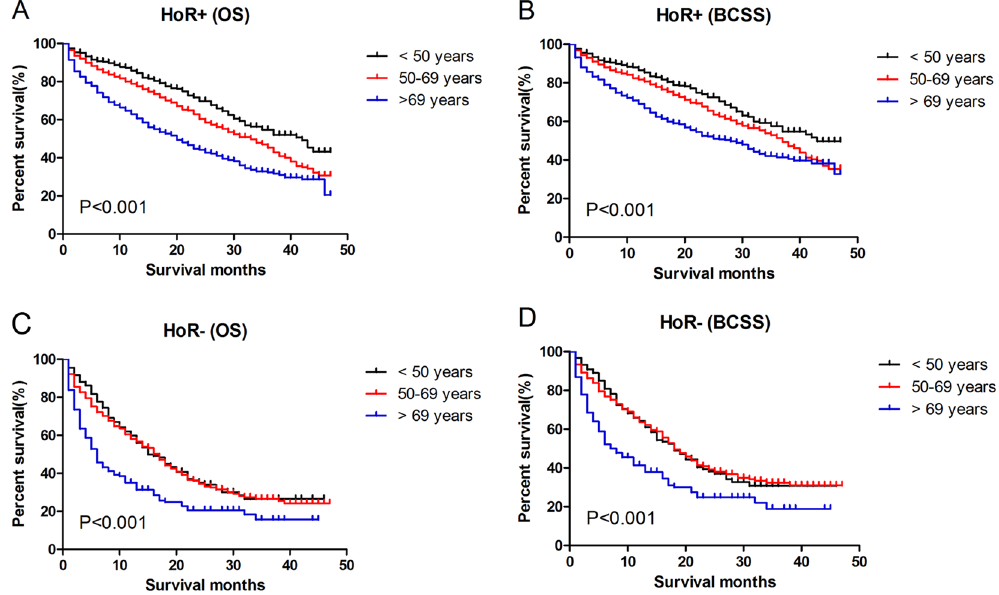
Figure 2. Comparison of survival in breast cancer patients with different hormone receptor status. Kaplan Meier analysis for OS and BCSS in different subgroups were shown in the graph. In hormone receptor positive ( A , B ) patients, the prognosis became worse with the increase of age (P < 0.001). In hormone receptor negative patients ( C , D ), middle-aged patients had similar survival to younger patients (P > 0.05), though older patients still had the worst prognosis. HoR + : hormone receptor positive; HoR-: hormone receptor negative.